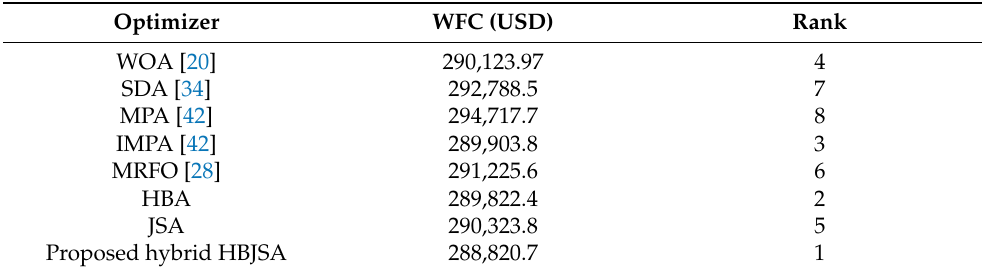
Figure 7. Convergence rates of the proposed HBJSA versus the HBA and JSA for the 84-unit system of CHP economic dispatch. Table 6. Comparison between HBA, JSA, and HBJSA with respect to reported techniques for the 84-unit system of CHP economic